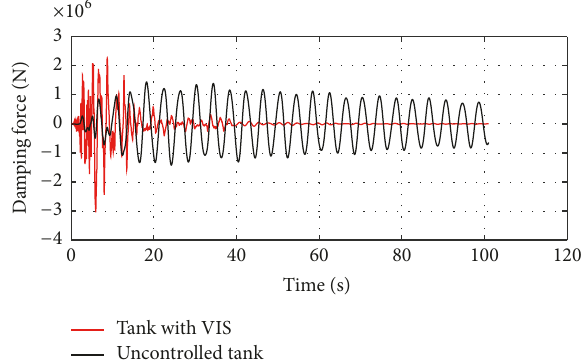
Figure 21: Output forces of the tank with the VIS and the uncontrolled tank under the excitation of the Kobe